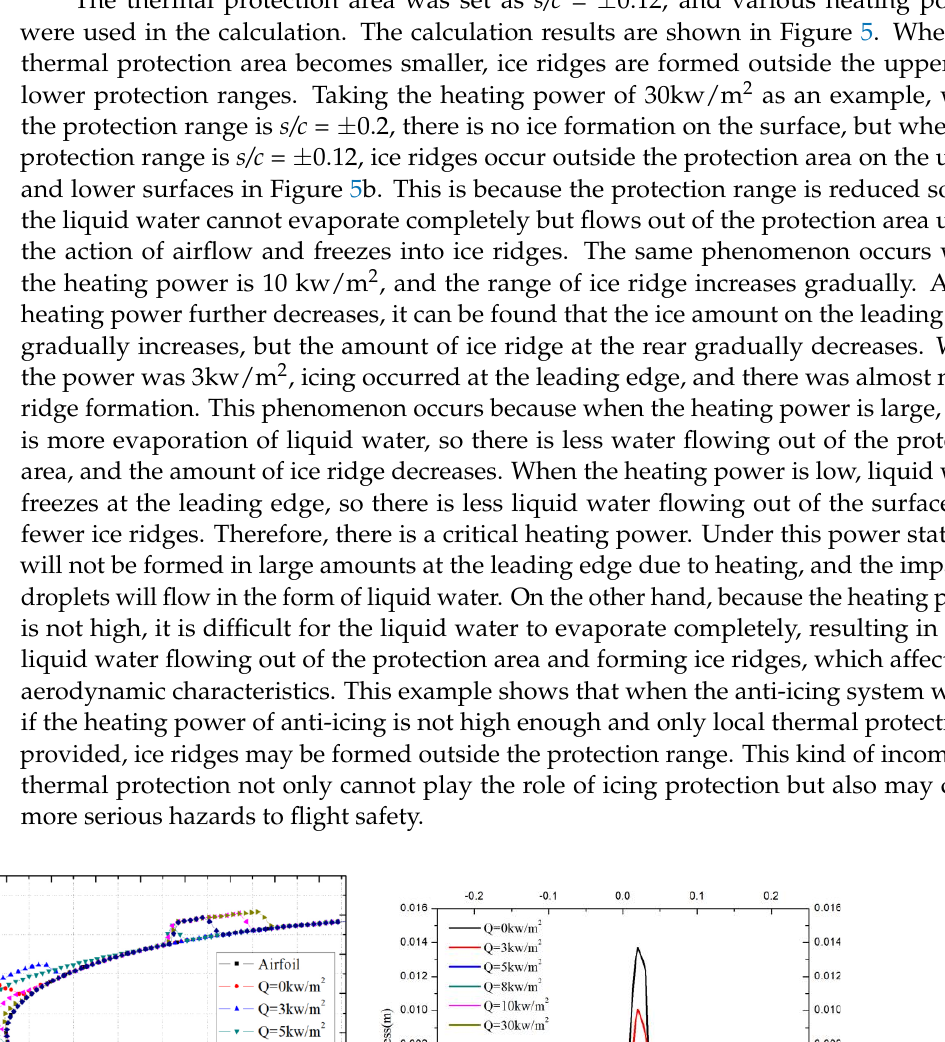
Figure 5. Icing characteristics with protection range of s / c = ±0.12: ( a ) Ice shapes; ( b )Ice thickness.